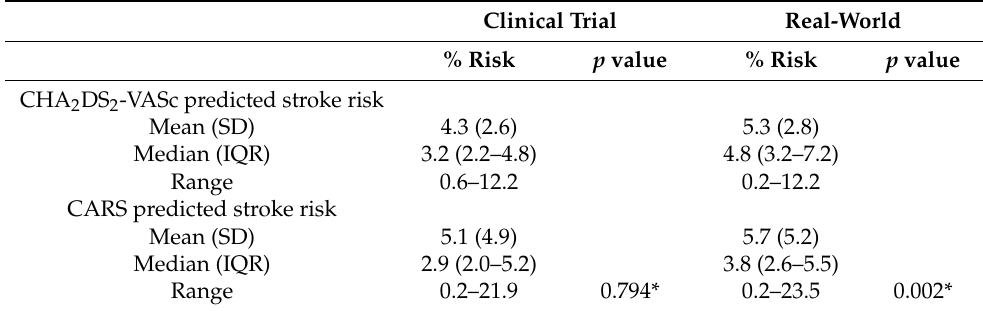
Table 3. Comparison of overall predicted 1-year stroke risk by CARS vs. CHA 2 DS 2